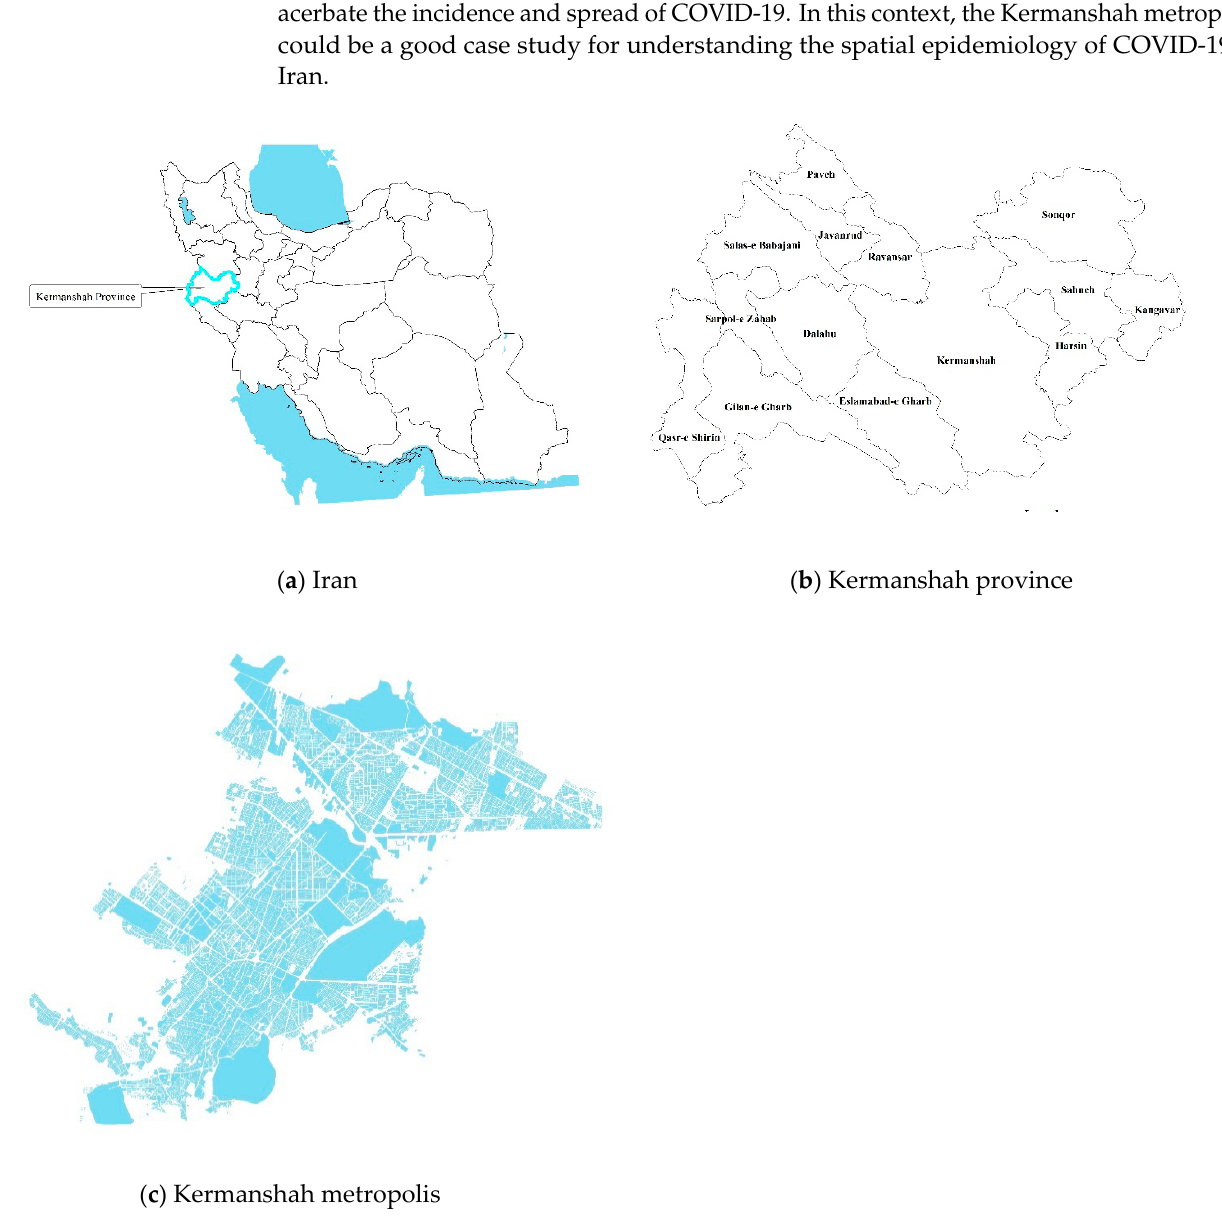
Figure 1. ( a – c ) Location of Kermanshah metropolis in Kermanshah Province, Iran (source: authors).